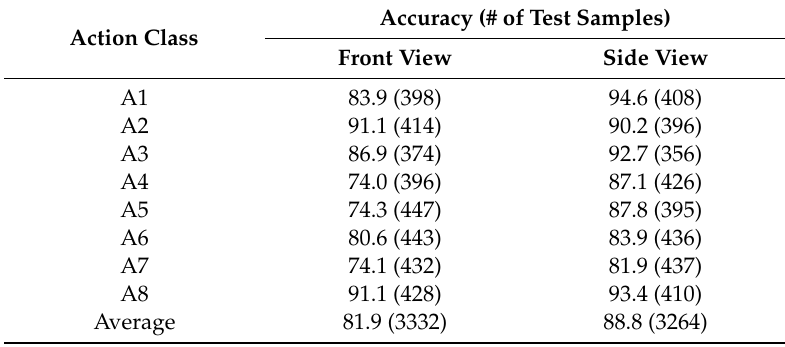
Table 7. Recognition accuracy according to the camera view and action class.